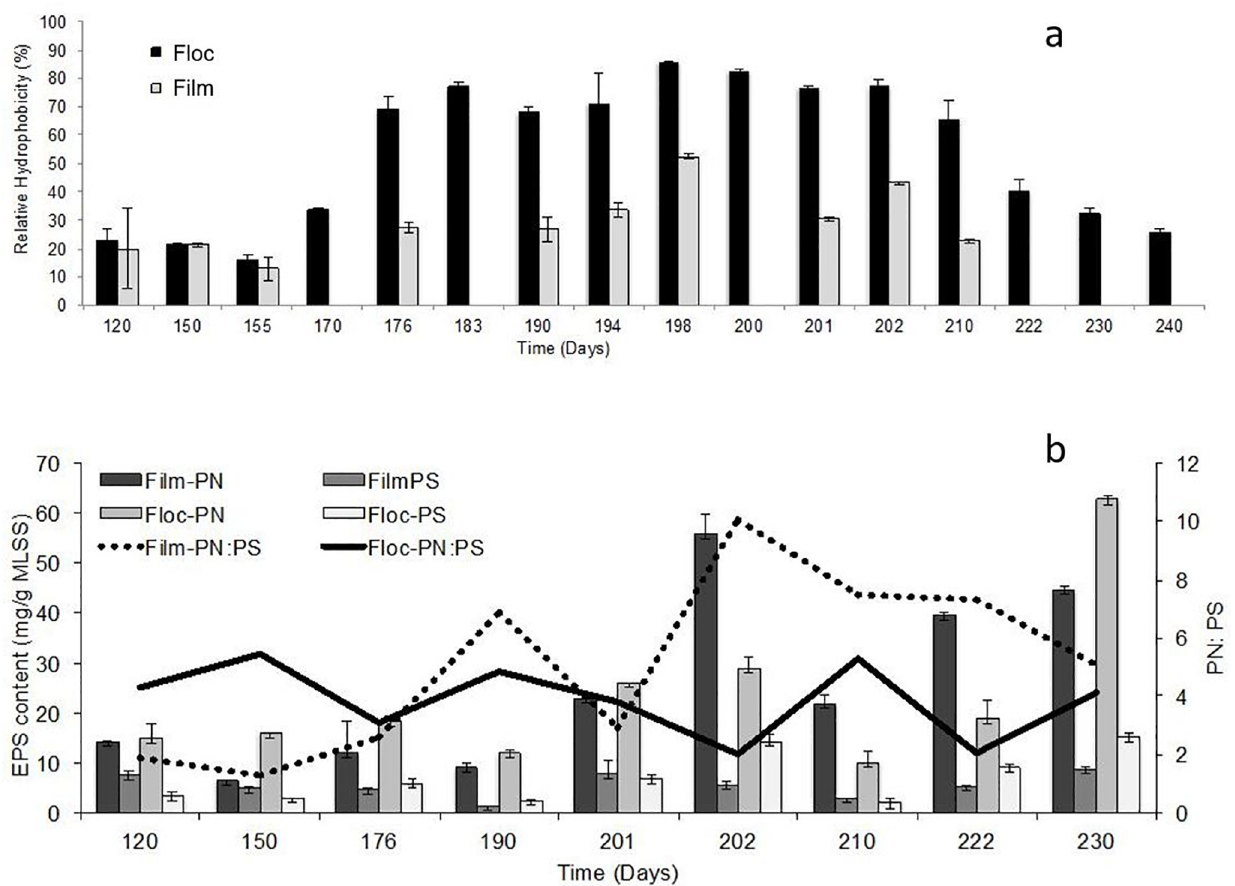
Fig 6. Physical-chemical properties of biofilms and flocs in LS IF-SBR system. (a) Relative hydrophobicity; (b) Composition of EPS.